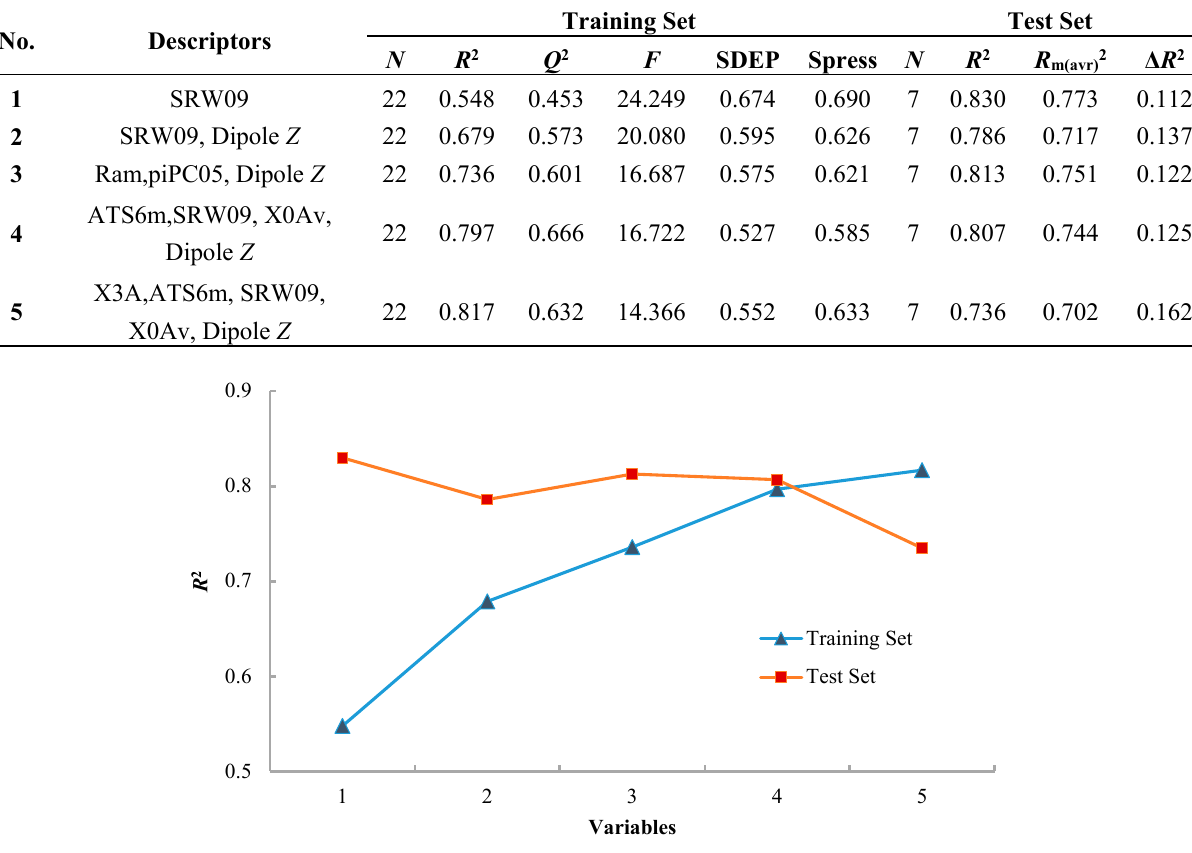
Figure 2. Comparison of the regression coefficients ( R 2 ) for the training and test